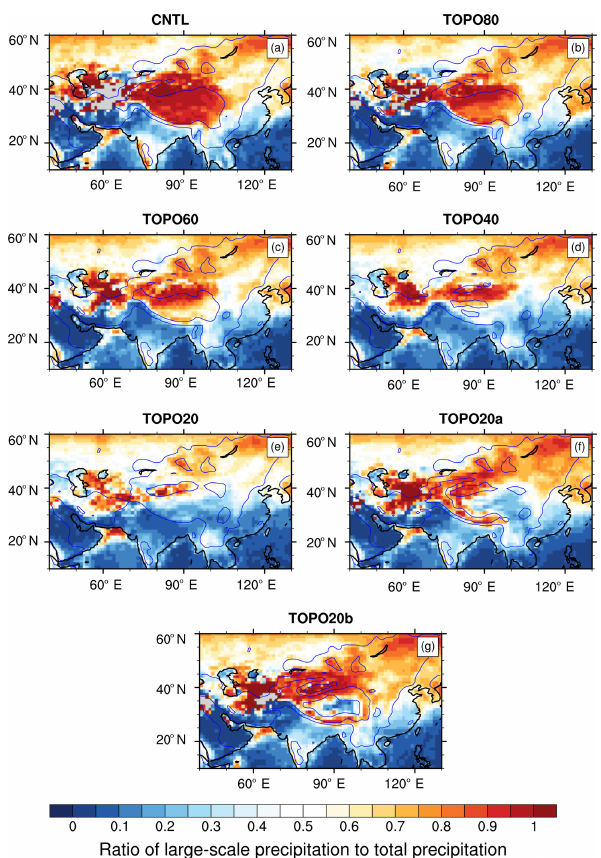
Figure 11. Ratio of summer large-scale to total precipitation rate in the (a) CNTL, (b) TOPO80, (c) TOPO60, (d) TOPO40, (e) TOPO20, (f) TOPO20a, and (g) TOPO20b cases. Blue lines mark the 500 and 2000m elevation contours in each case. In the Hi- malayas, this ratio decreases when mountain elevations are reduced. As a result, large-scale precipitation is dominant in high-elevation scenarios, but not in low-elevation